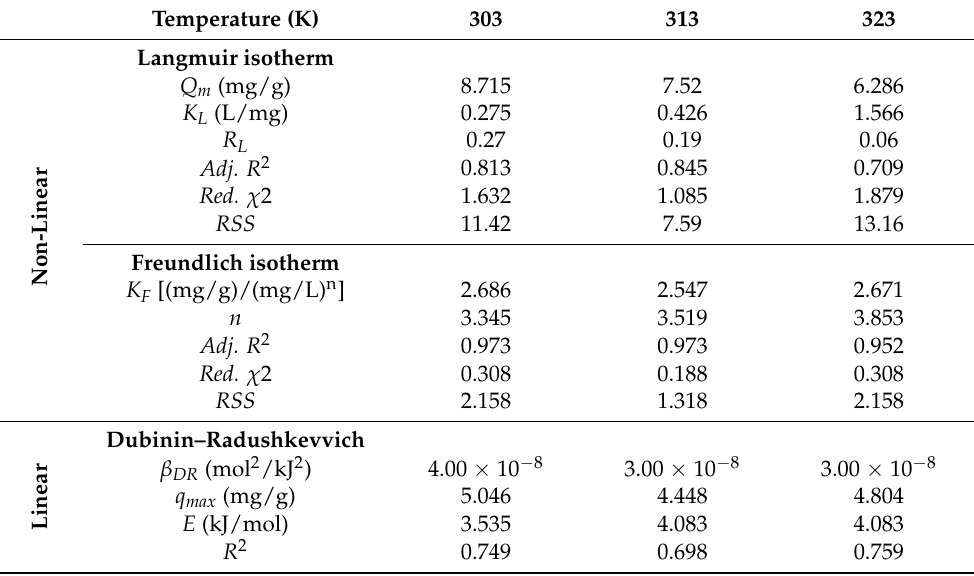
Table 3. Isotherm parameters for the sorption of fluoride by CNF-AgMgOnHaP composite. Temperature (K) 303 313 323 Langmuir isotherm Q m (mg/g) 8.715